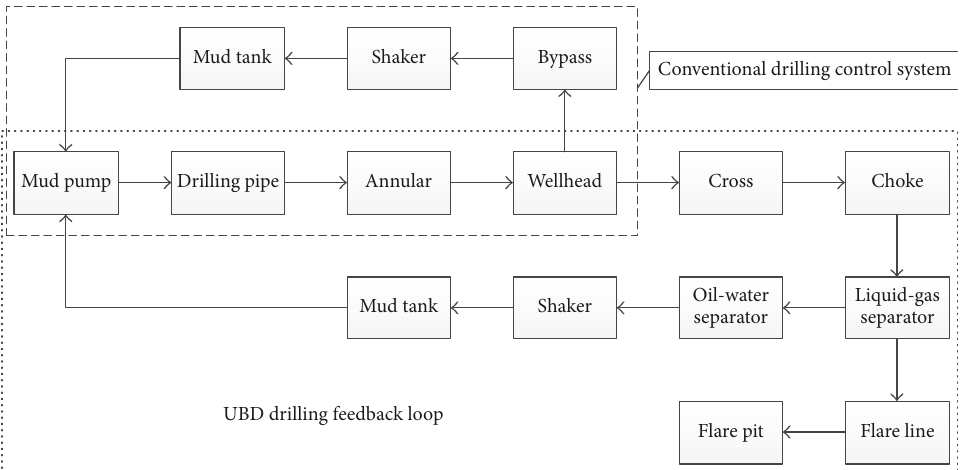
Figure 2: Control and feedback loop of underbalanced drilling.